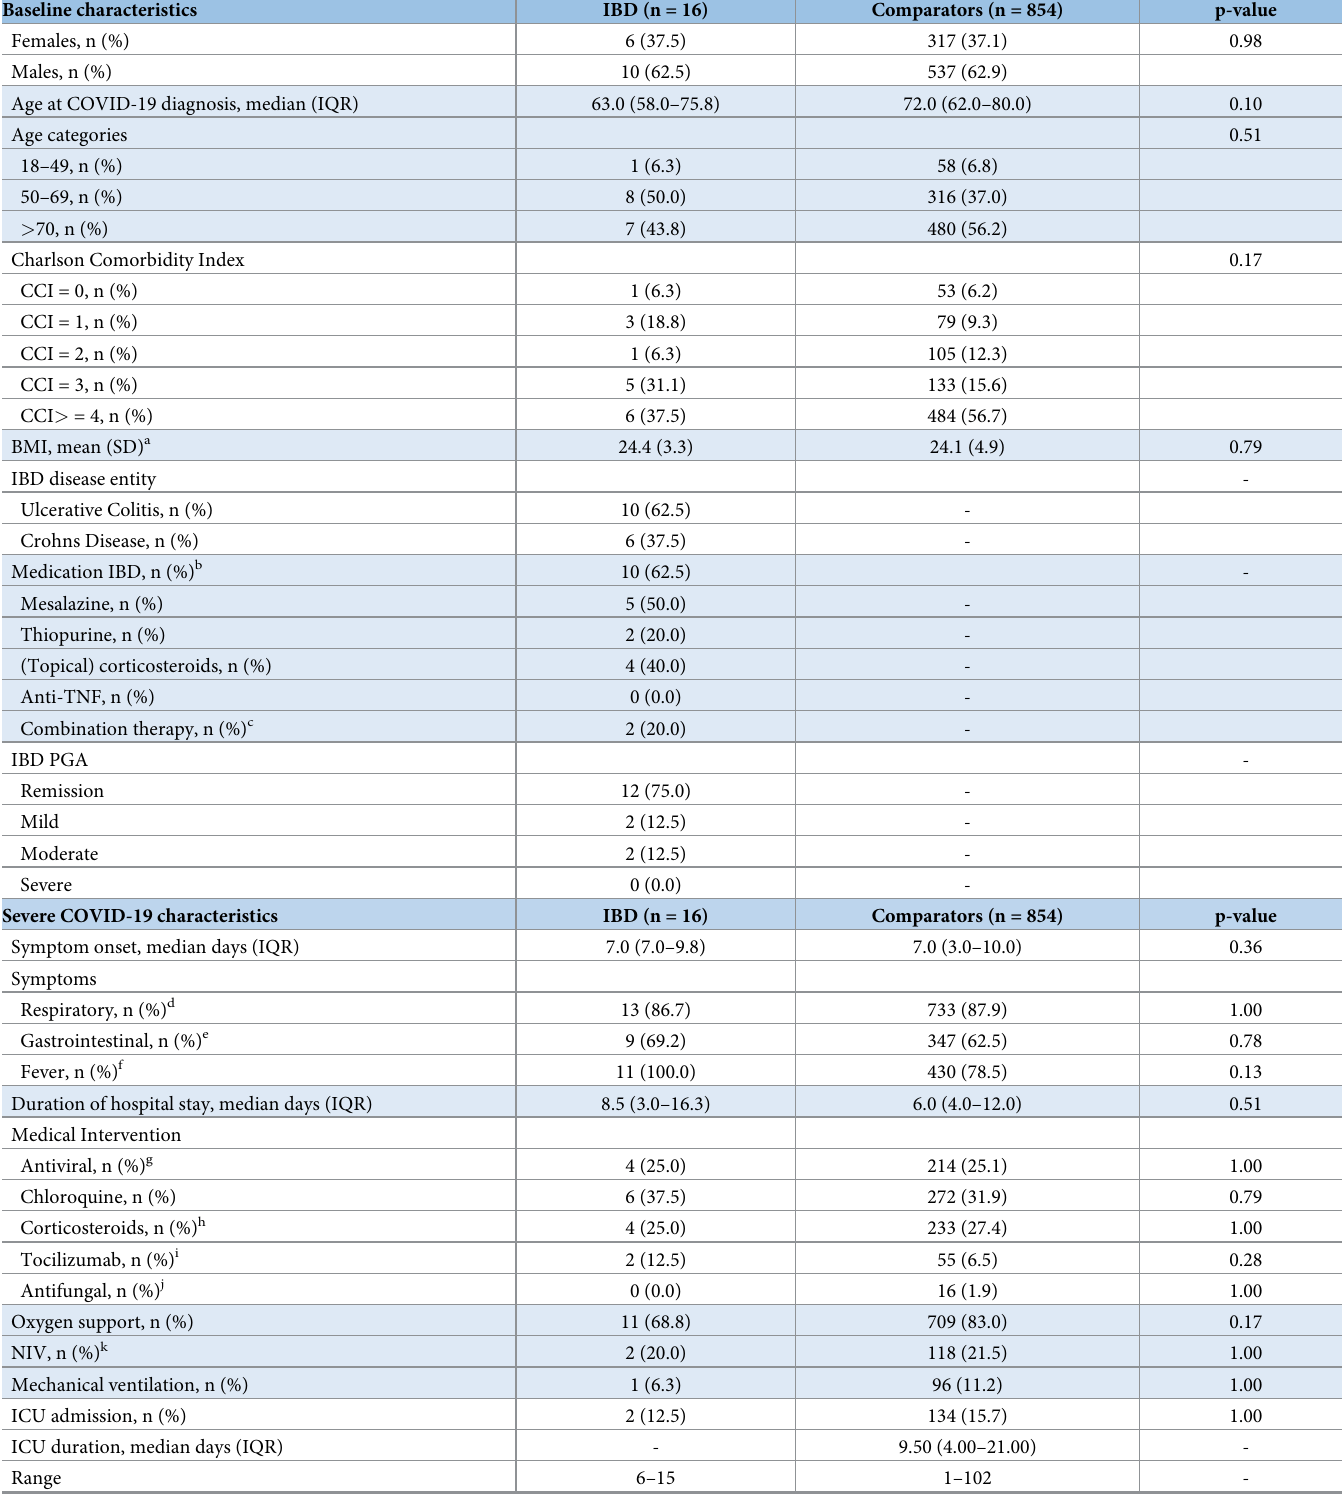
Table 2. Baseline and severe COVID–19 course characteristics of the IBD population and regional matched time frame